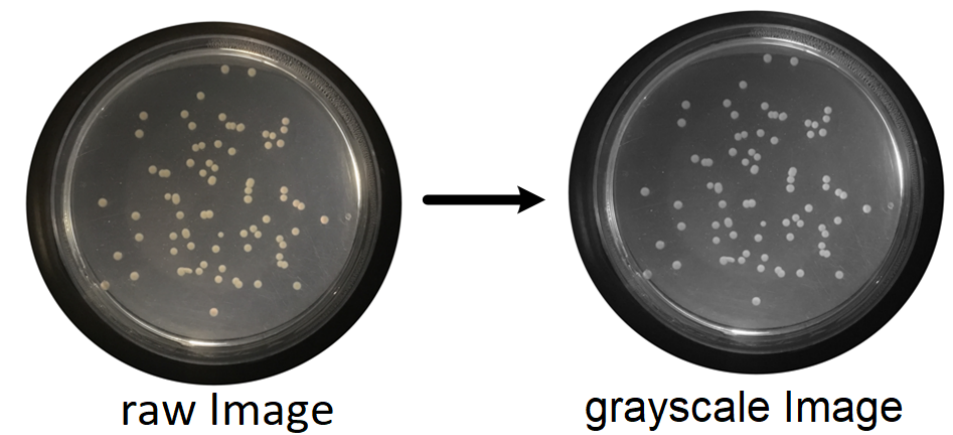
Figure 5. Conversion of raw color image to grayscale image.